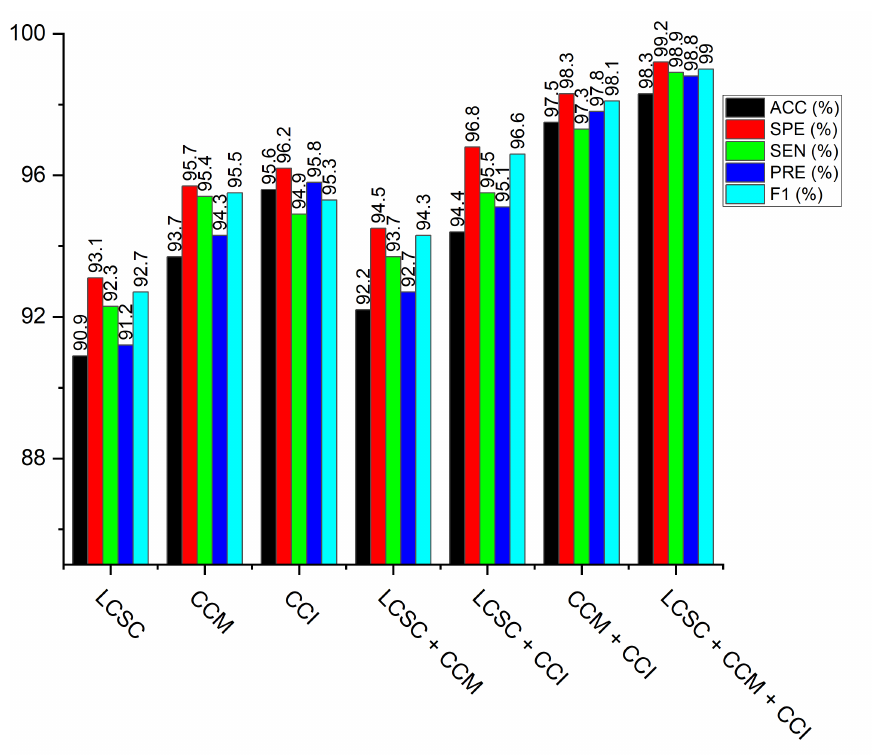
Figure 9. Performance of the proposed multi-channel in comparison with the single channels and dual channels across the different evaluation